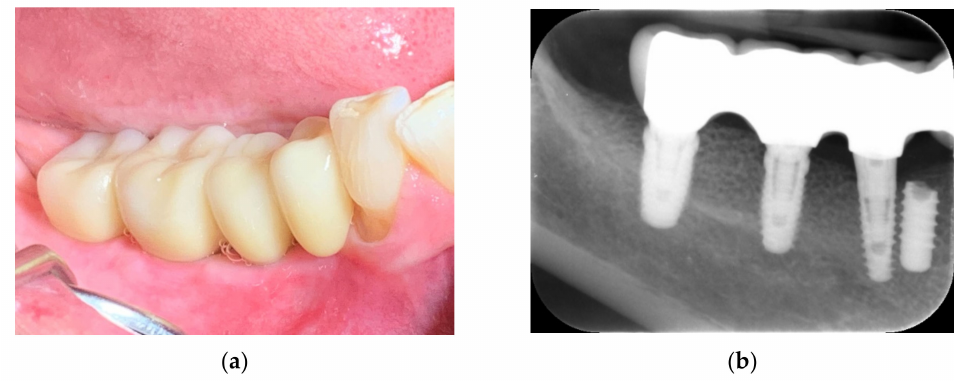
Figure 20. Bridge delivery ( a ) and control radiograph ( b ).